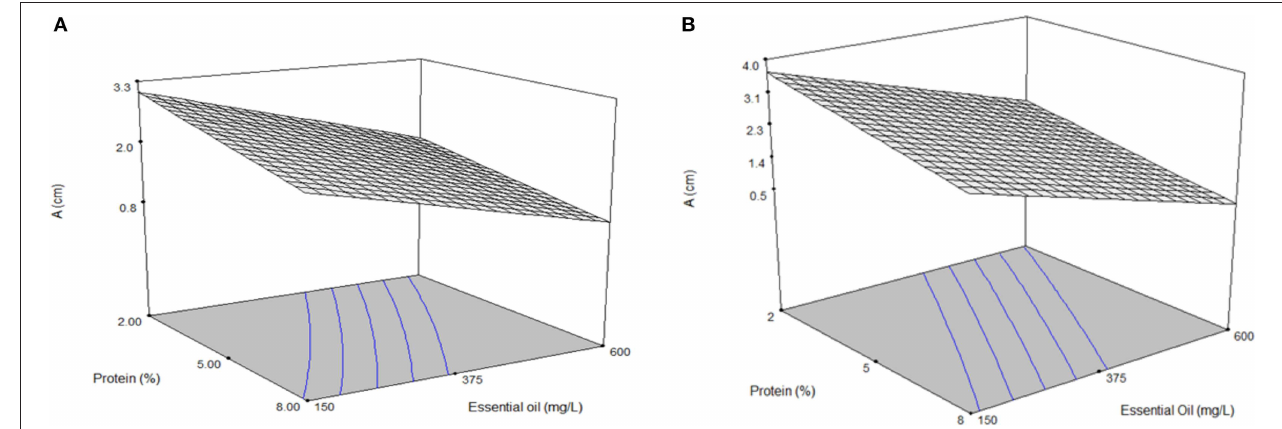
FIGURE 2 | Response surface graphs of the kinetic parameter A, when evaluating protein content and essential oil high in carvacrol ( Lippia berlandieri Schauer) against both fungal strains: (A) Penicillium expansum . (B) Aspergillus ochraceus